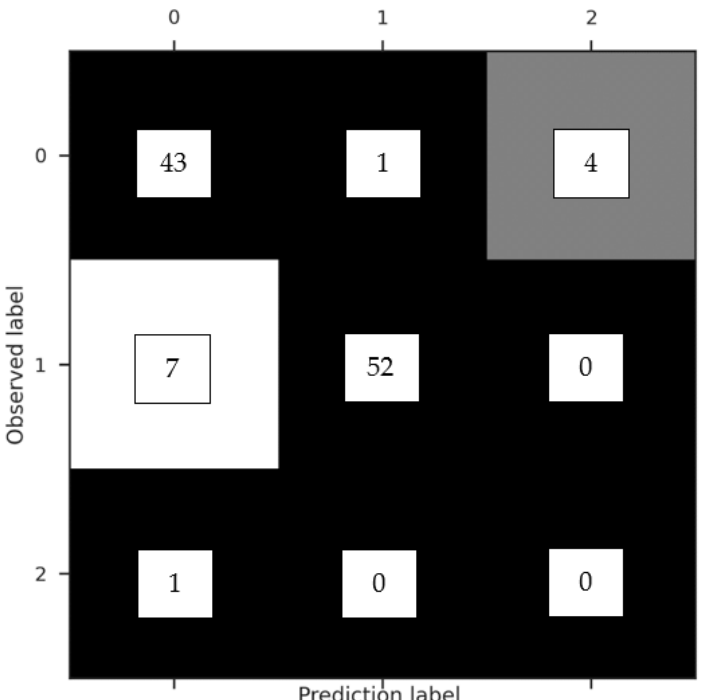
Figure 4. Confusion matrix (black—predicts the correct class; white—predicts incorrectly; grey—the chance of incorrectly predicting is small). Table 5. Classification report (random forest).